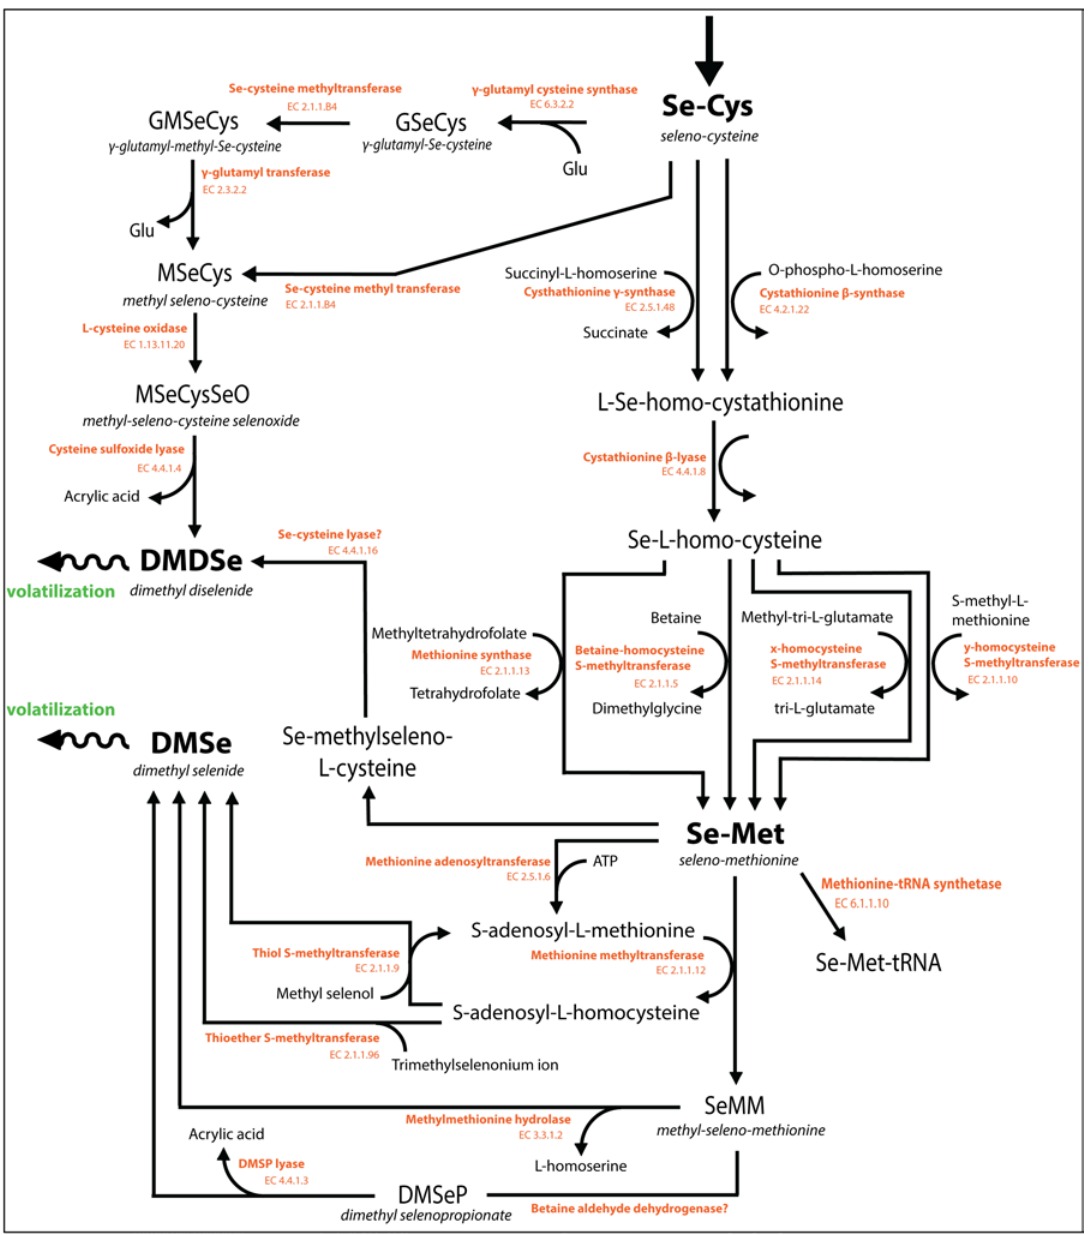
Figure 5. Schematic of the biochemical reactions involved in Se methylation in plants and microorganisms. Identified catalyzing enzymes and their EC numbers are given in orange at the corresponding pathways. Major (intermediate) compounds and volatile end-products are indicated in bold. Information is compiled from